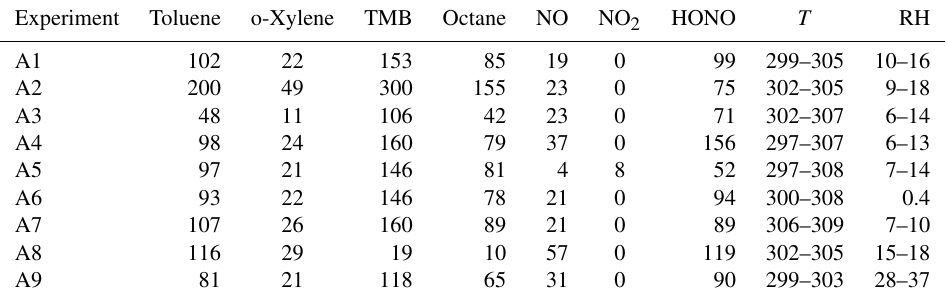
Table 2. Initial concentrations in ppb, temperature ( T ) in Kelvin and relative humidity in % for anthropogenic experiments. SO 2 was not present for those